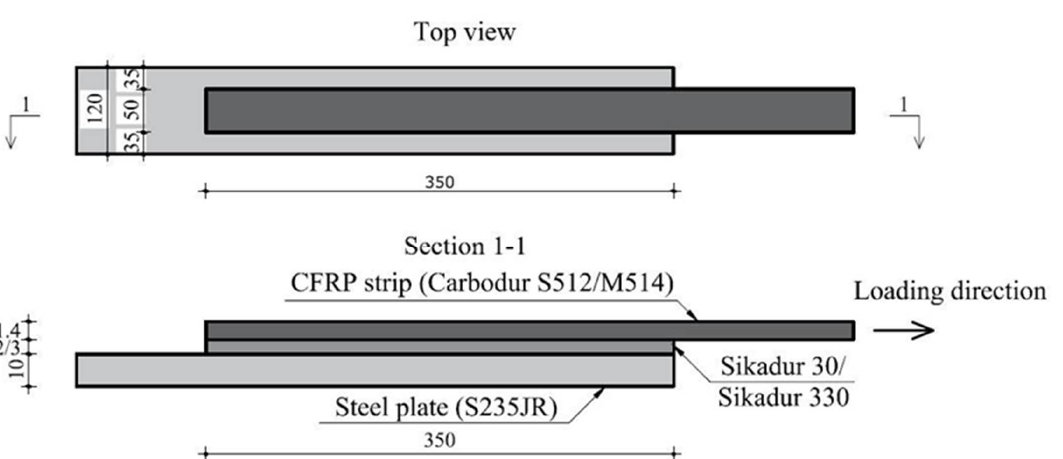
failure mechanisms recorded during the experimental tests.